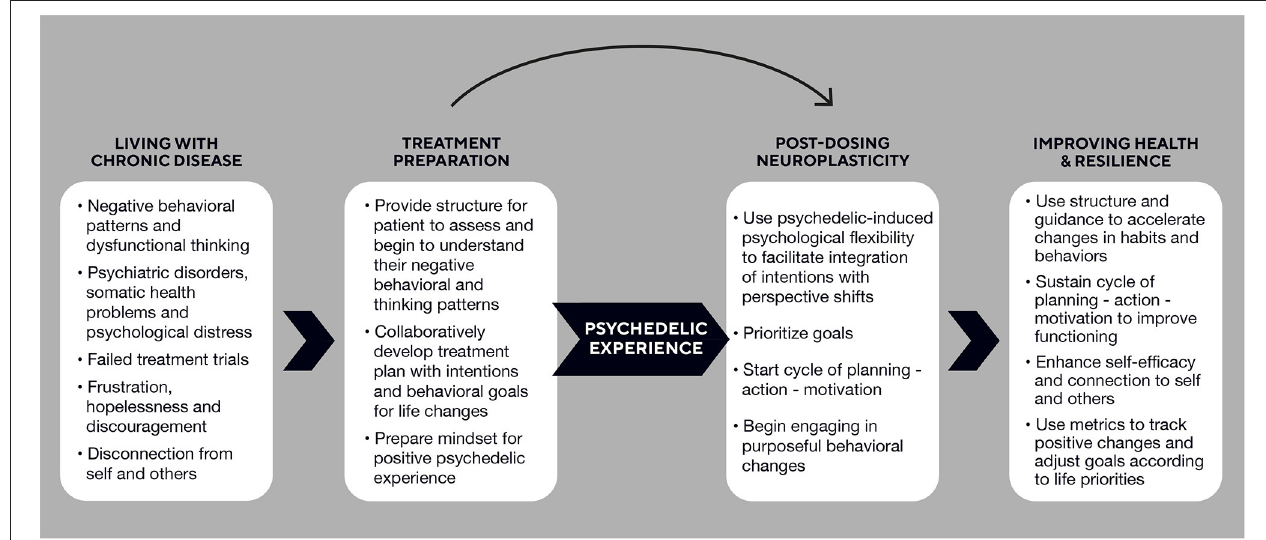
FIGURE 1 | Path of Behavioral Psychedelics to foster intentional changes in behaviors and habits to improve health and